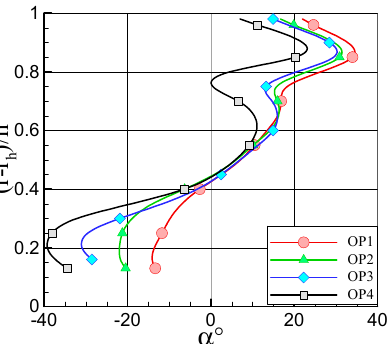
Figure 2. Absolute flow angle downstream of the stage for the different Operating condition (OP).